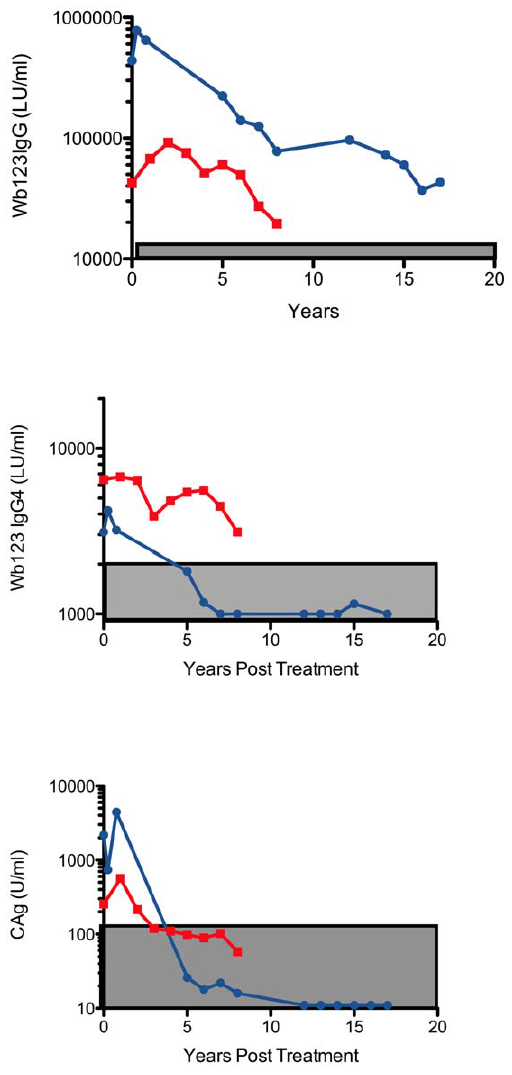
Figure 5. Antibodies to Wb123 fail to normalize following definitive anti-filarial treatment. IgG (Top panel) and IgG4 (Middle panel) anti-Wb123 antibodies in two individual patients followed longitudinally over an 8 (red line) or 17 (blue line) year period following definitive anti-filarial chemotherapy. Circulating antigen levels in the same two subjects is shown (Bottom panel). Gray shaded boxes show the normal range for each assay.